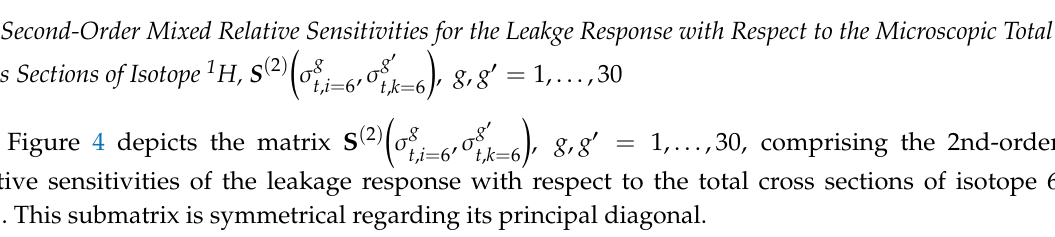
Table 15. Components of S ( 2 )